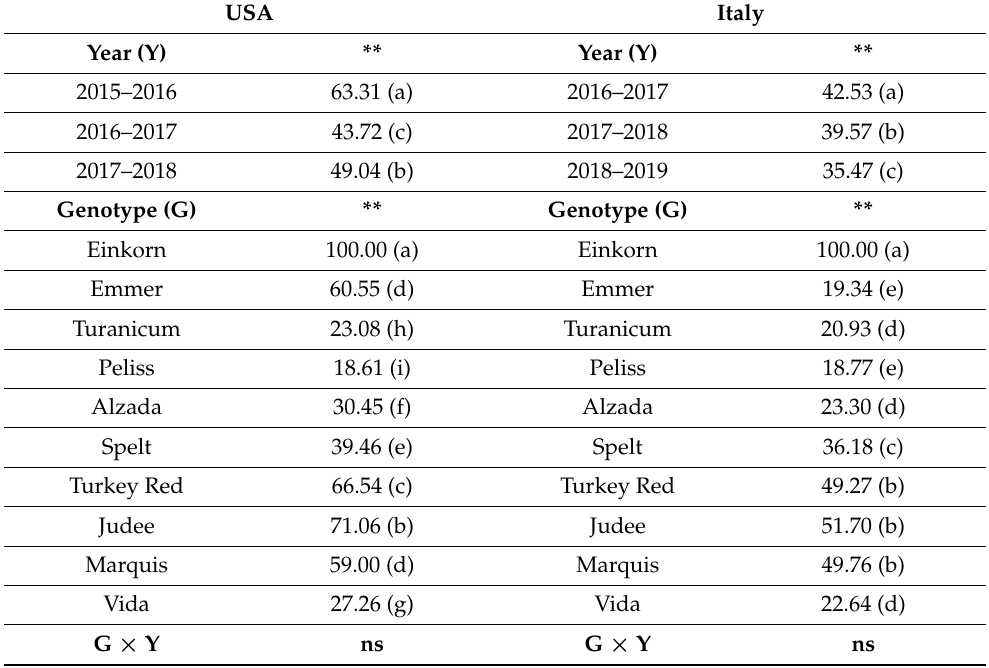
Table 3. Mean values (%) of the trypsin inhibitory activity for wheat genotypes, years and growing areas. Different letters indicate statistically significant different means for p < 0.05, ** p < 0.01. ns, not significant.